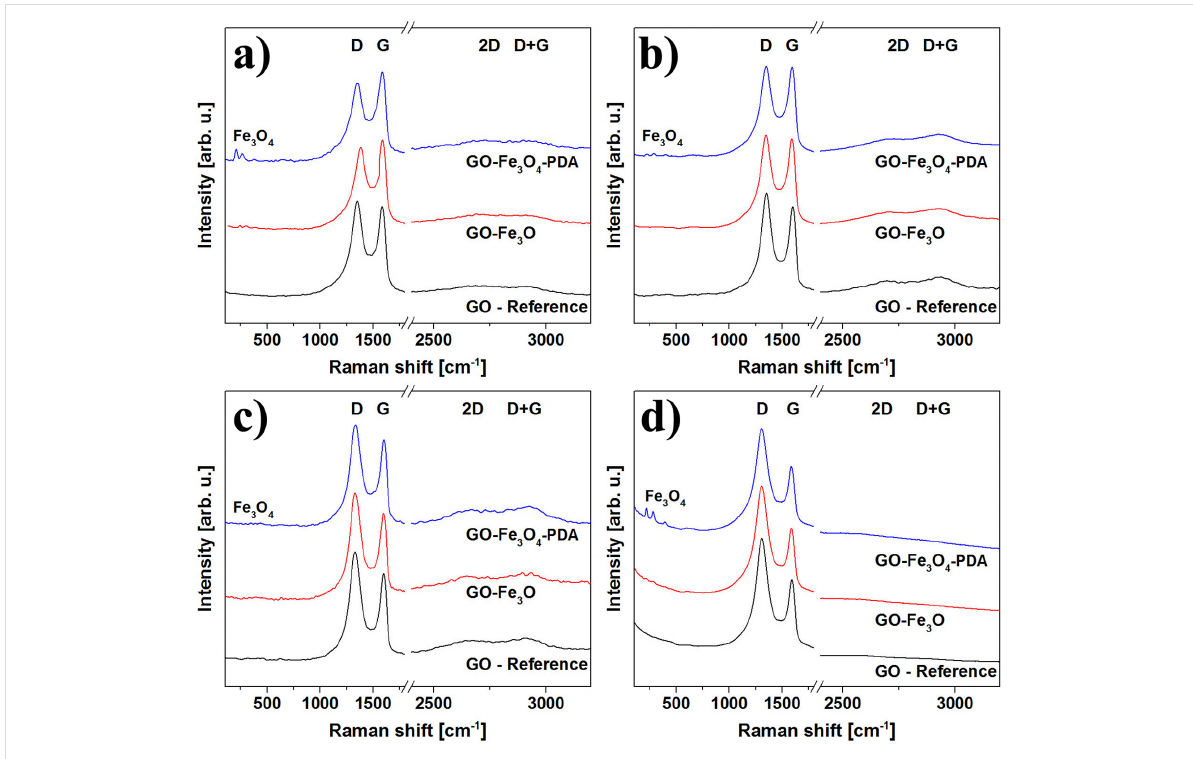
Figure 3: Raman spectra of rGO, rGO-Fe 3 O 4 and rGO-PDA@Fe 3 O 4 aerogel samples: λ = 488 nm (a), 514 nm (b), 633 nm (c) and 785 nm (d).